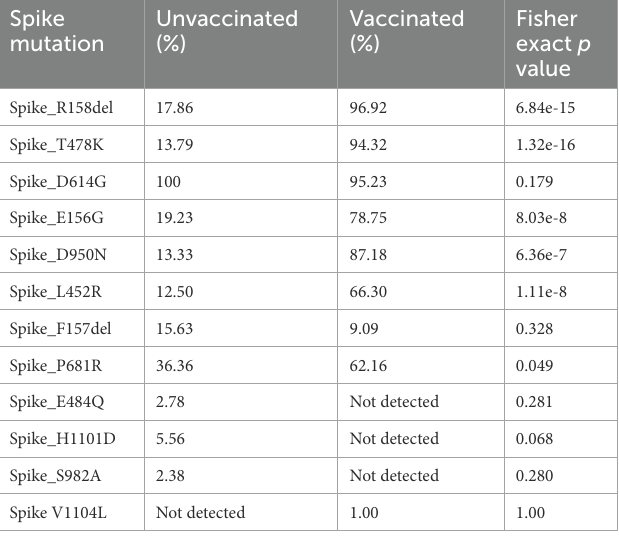
TABLE 1 The comparison of frequencies of the Spike mutations between vaccinated and unvaccinated COVID-19 patients during the second wave. Spike Unvaccinated mutation (%)